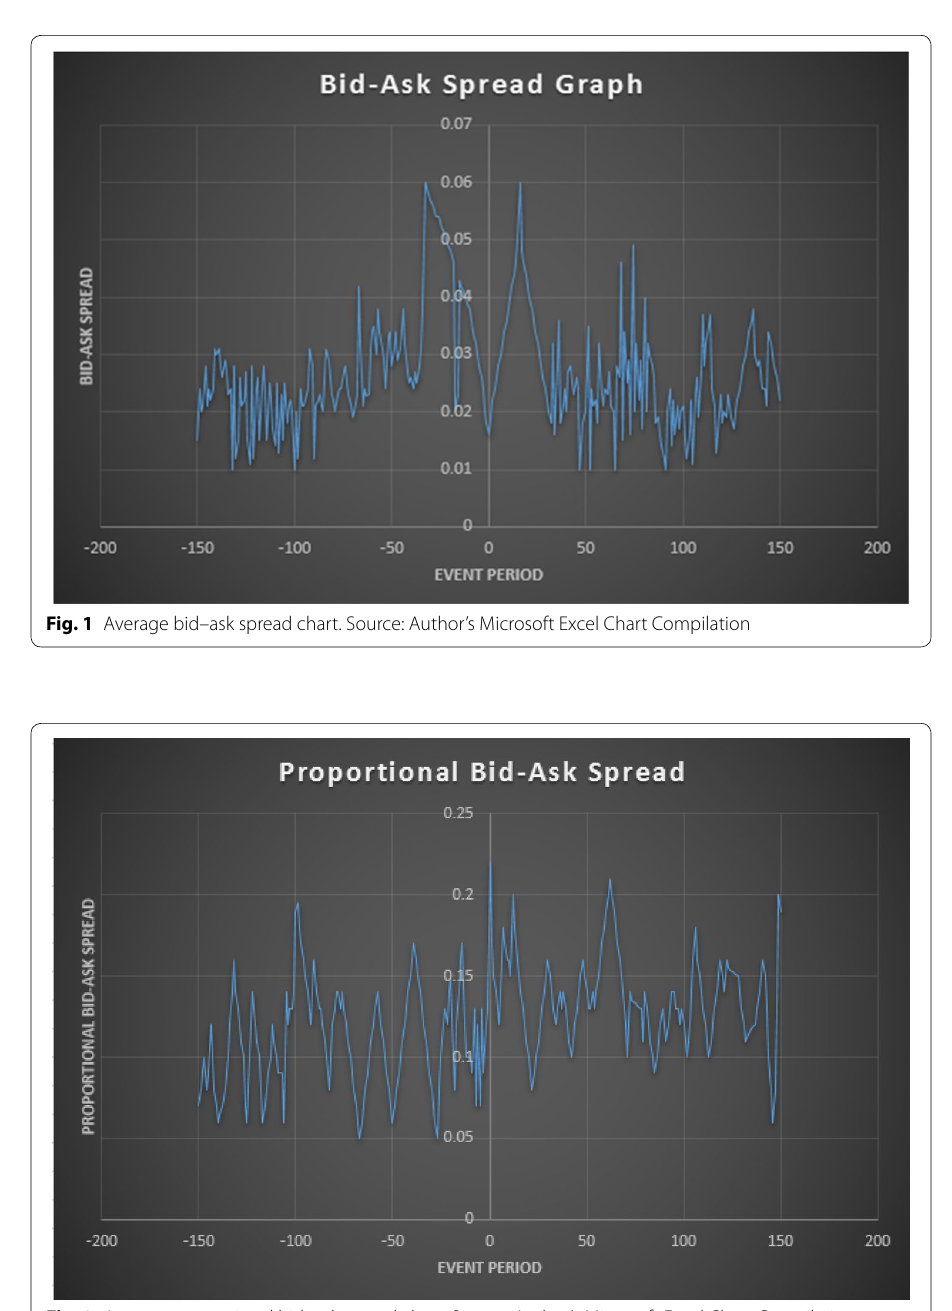
Fig. 2 Average proportional bid–ask spread chart. Source: Author’s Microsoft Excel Chart